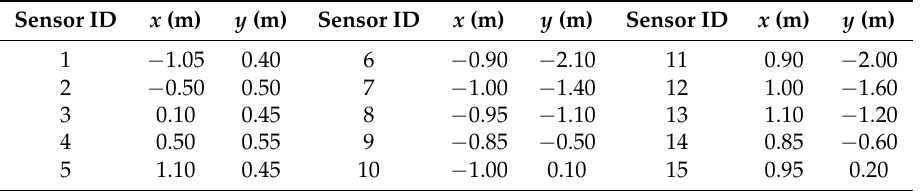
Table 3. Positions of the Microwave Sensors in the Second Simulated